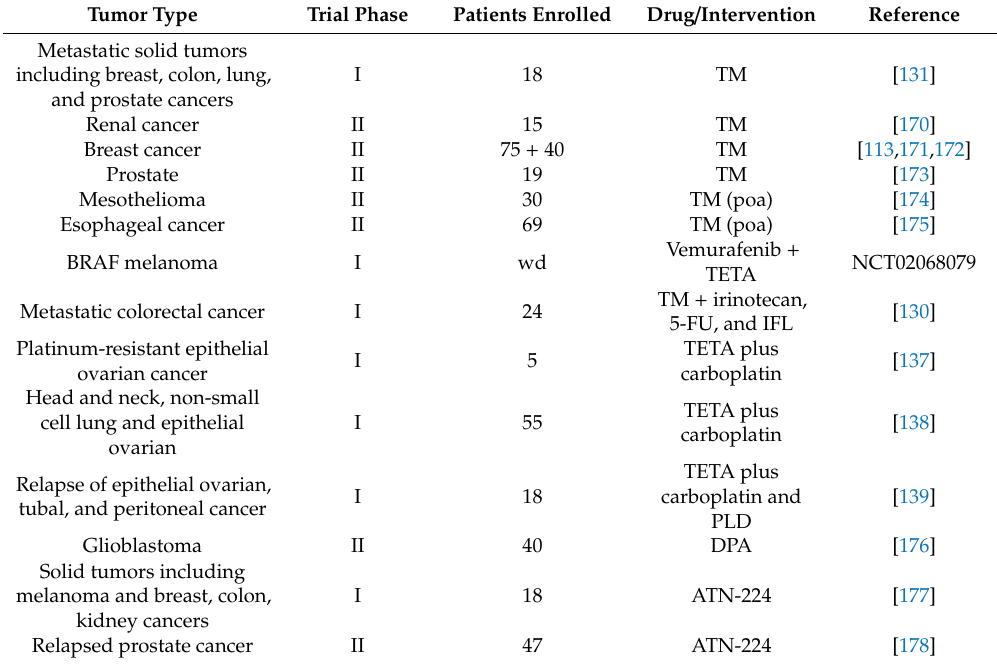
Table 4. Copper chelation therapy clinical trials for